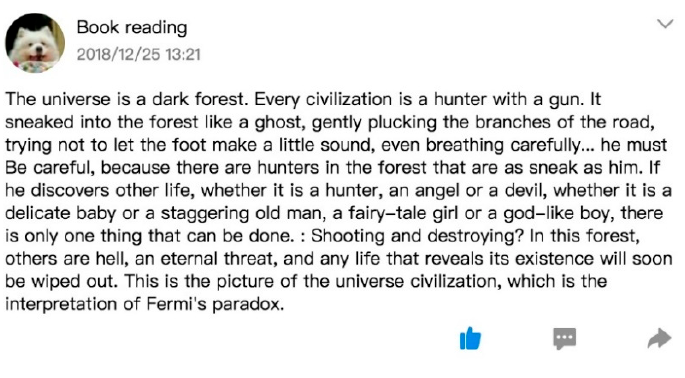
Figure 6. Data item in Tencent QQ Zone.